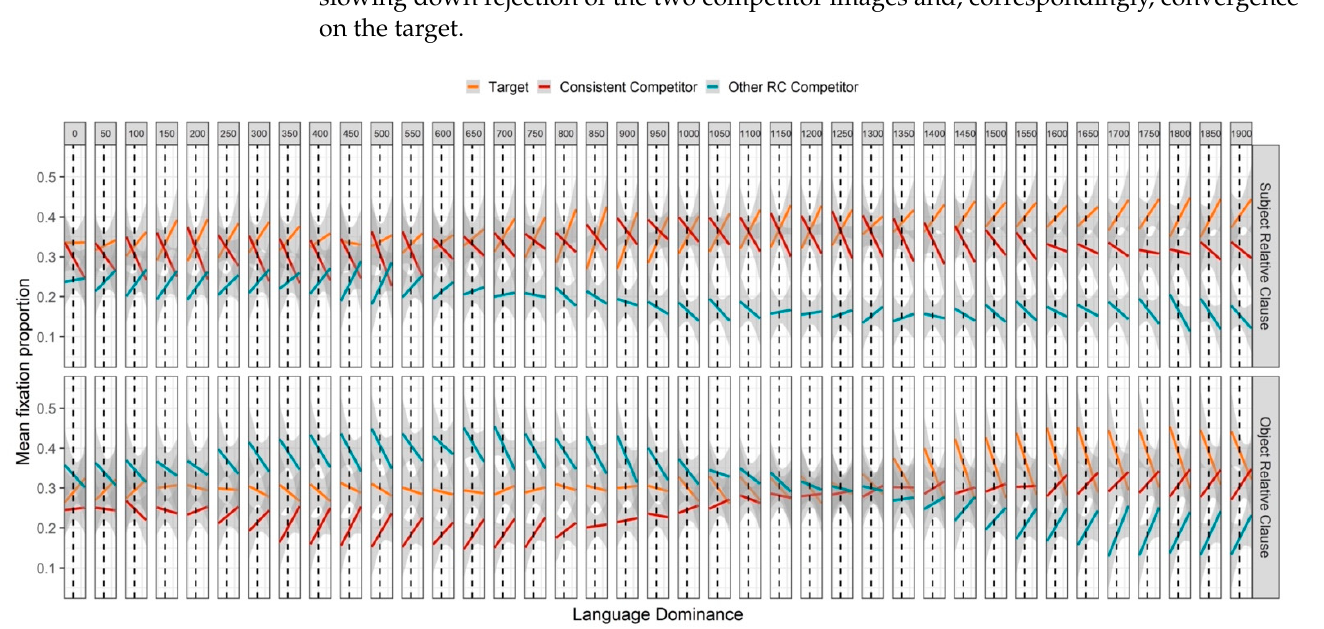
Figure 6. Same as Figure 4, but for the relative clause region.